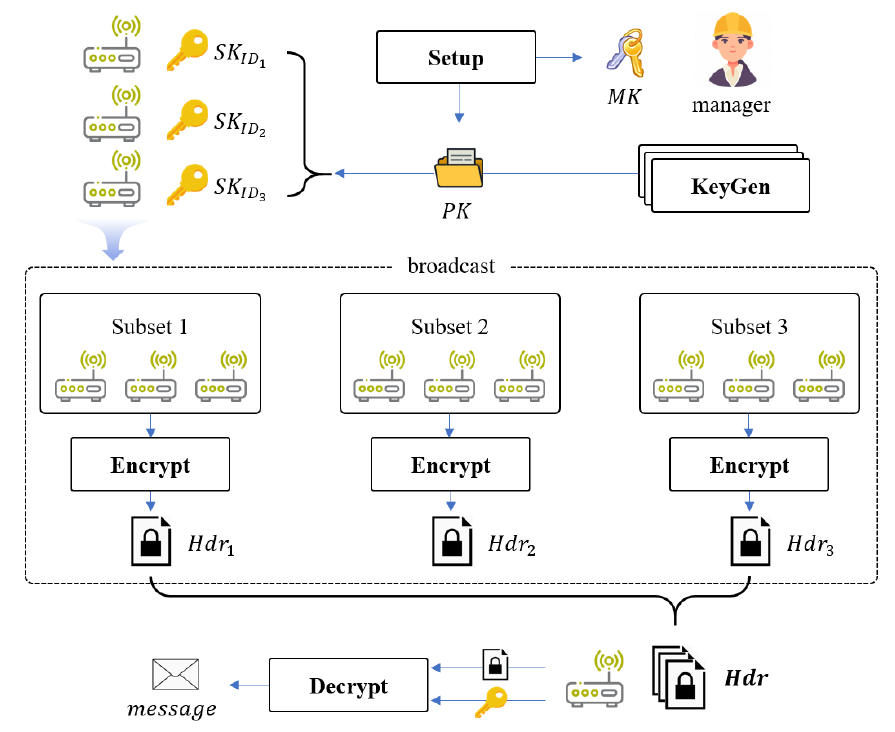
Figure 2. The general workflow of the public key broadcast